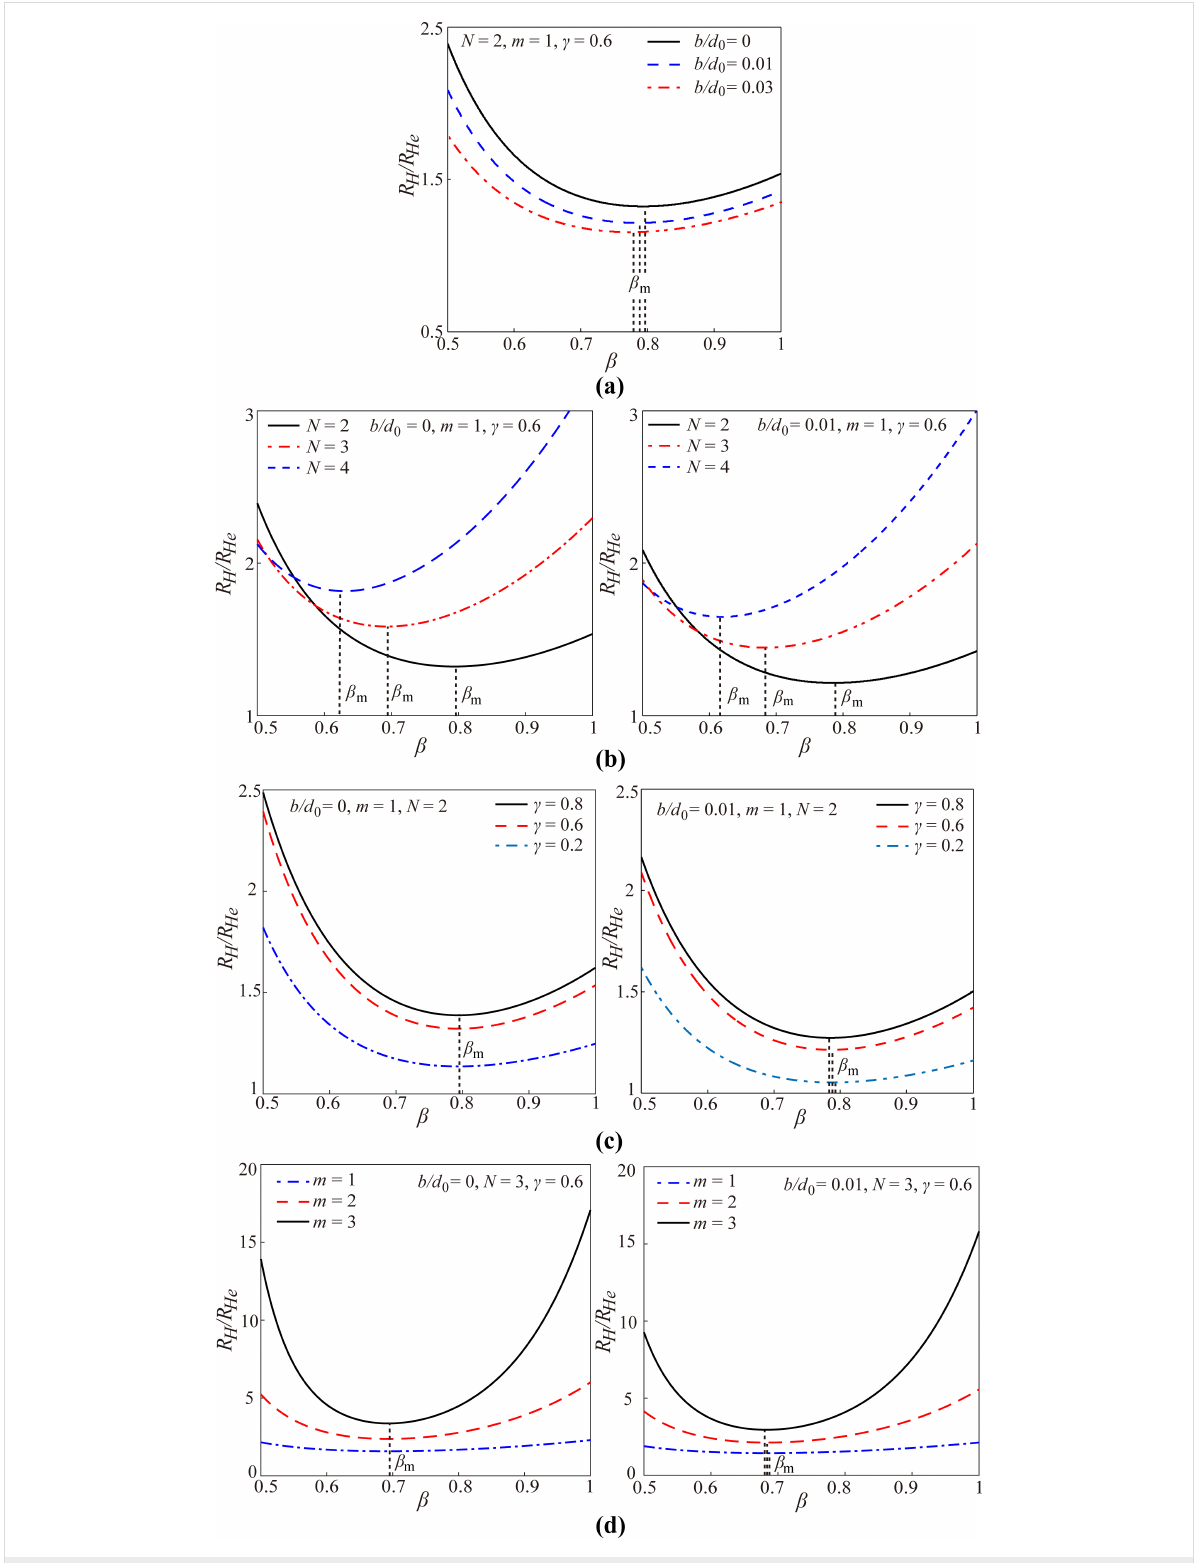
Figure 3: The dimensionless hydraulic resistance of laminar flow in a fractal tree-like microchannel network under both no-slip and slip conditions versus the diameter ratio β at different (a) ratios between slip length b and the diameter d 0 of channel at the 0th level, (b) the branching number N , (c) the length ratio γ and (d) the level number